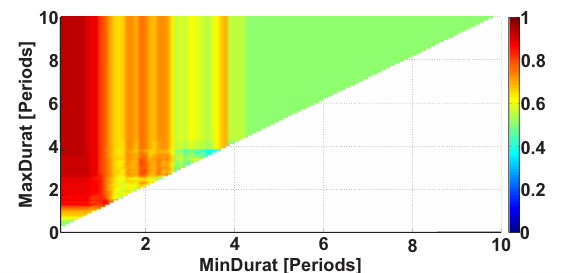
Figure 16. An example of the Duration AUC diagram. The following constraints are applied to the wave train parameters: a frequency from 8 to 20 Hz and a PSD no less than 30 µ V 2 / Hz. The abscissa axis indicates the lower bound of the range of the duration in periods; the ordinate axis indicates the upper bound of the range of the duration in periods. An intense red area appears inside the red region. The intense red area has the following coordinates: x-coordinates from 0 to 0.6 periods and y-coordinates from 3.6 periods and more.